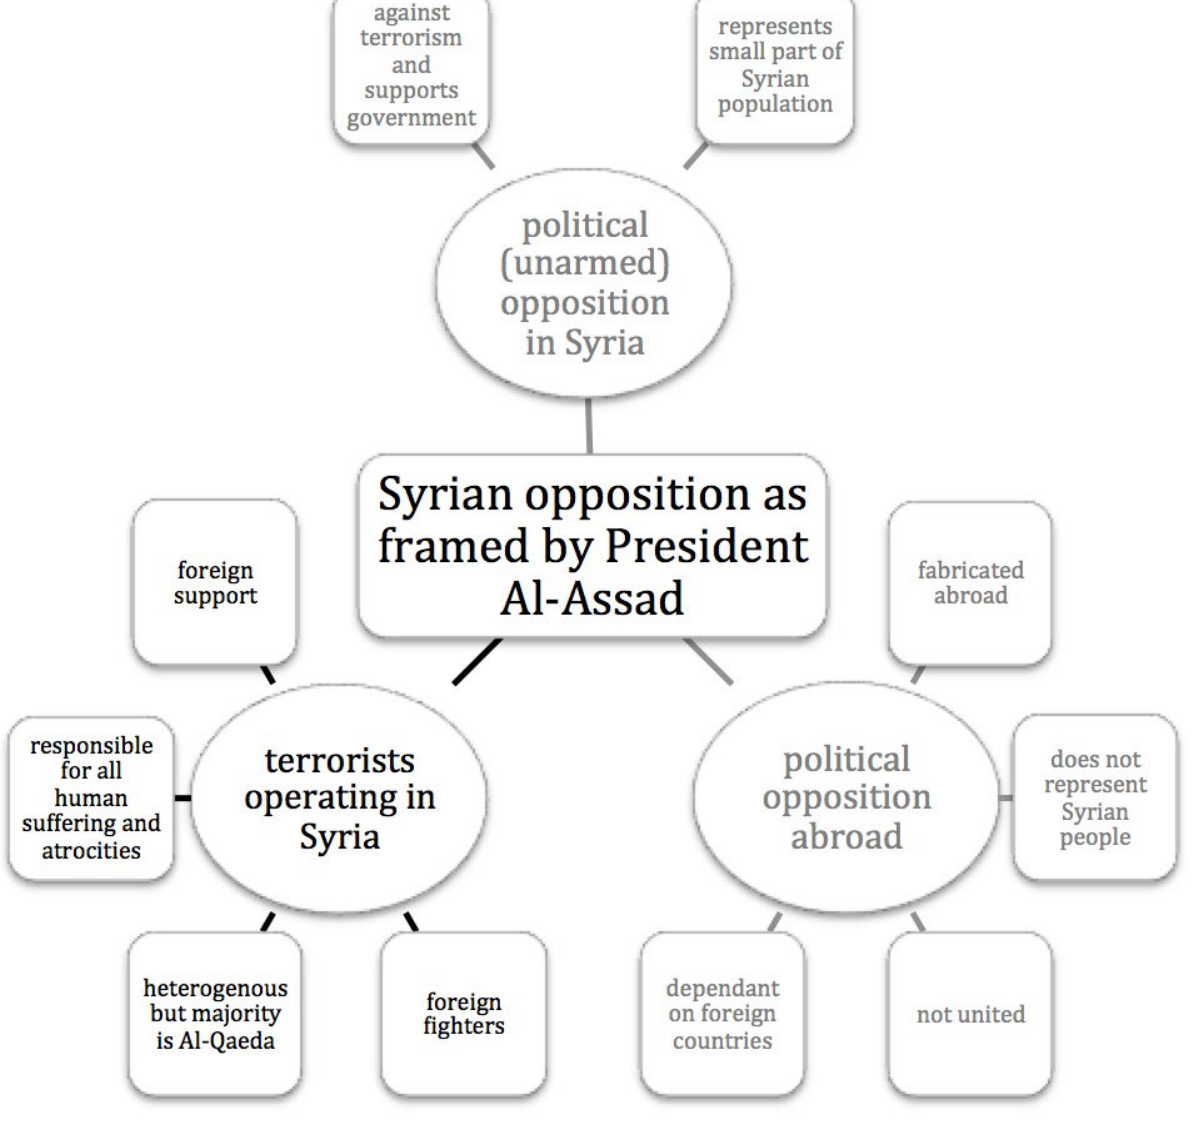
Figure 1: Thematic network of the Syrian opposition as framed by President